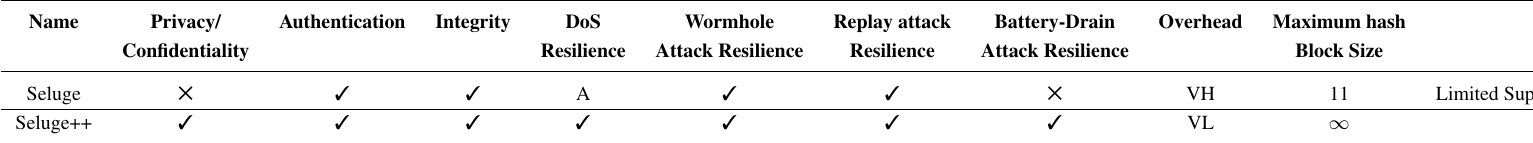
Table 5. Seluge and Seluge++ comparison in terms of security support. DoS, denial of